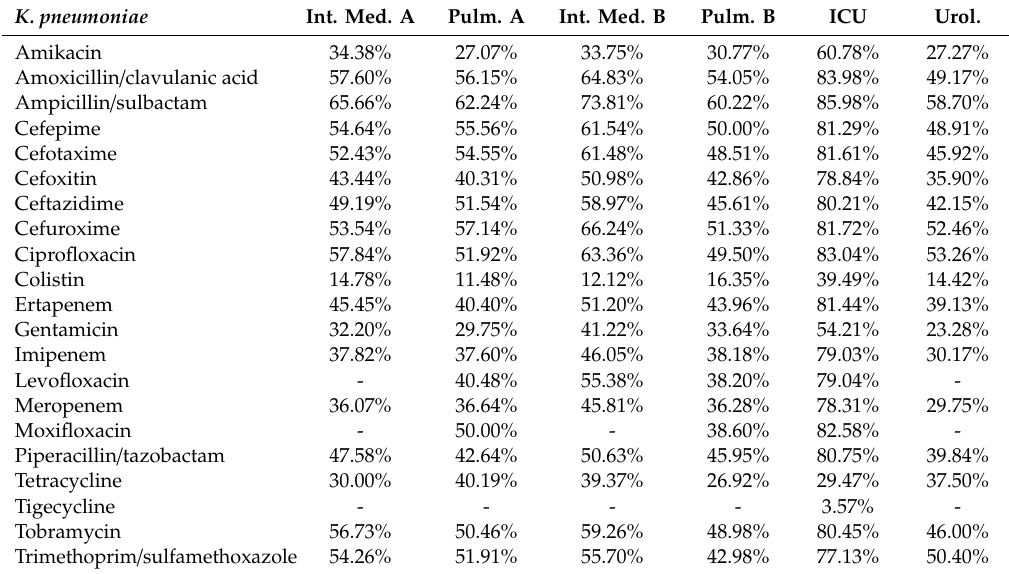
Table A8. Resistance rates for K. pneumoniae per ward per antibiotic during the 2 years